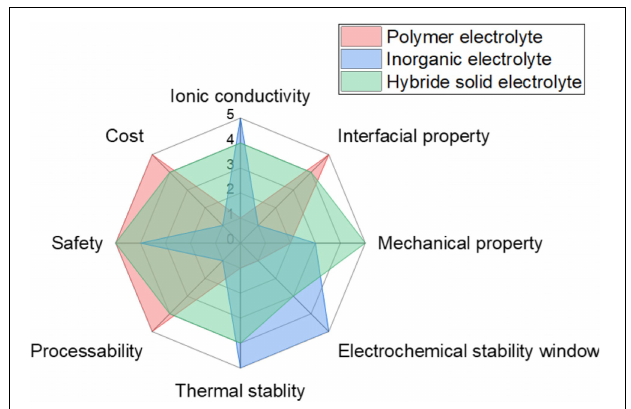
FIGURE 1 | Ranking of properties of solid electrolytes (5 = best, 1 =